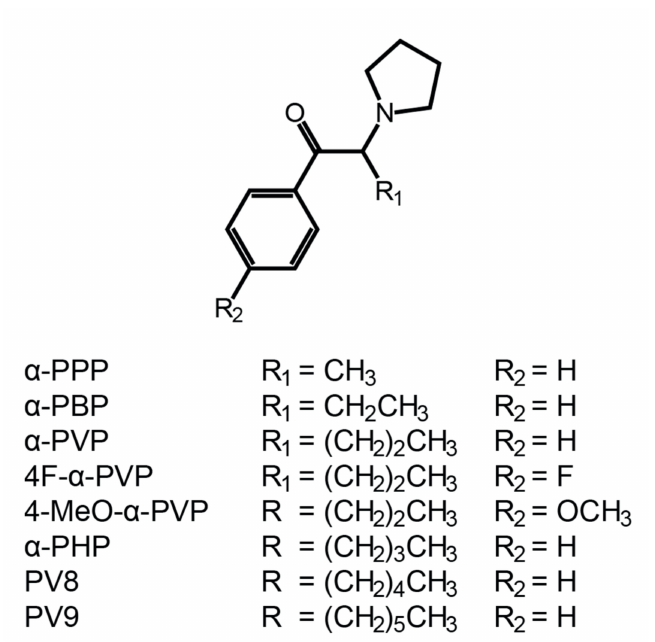
Figure 1. Chemical structures of α -PHP, 4F- α -PVP, and structural analogues α -PPP, α -PBP, α -PVP, 4-MeO- α -PVP, PV8, and